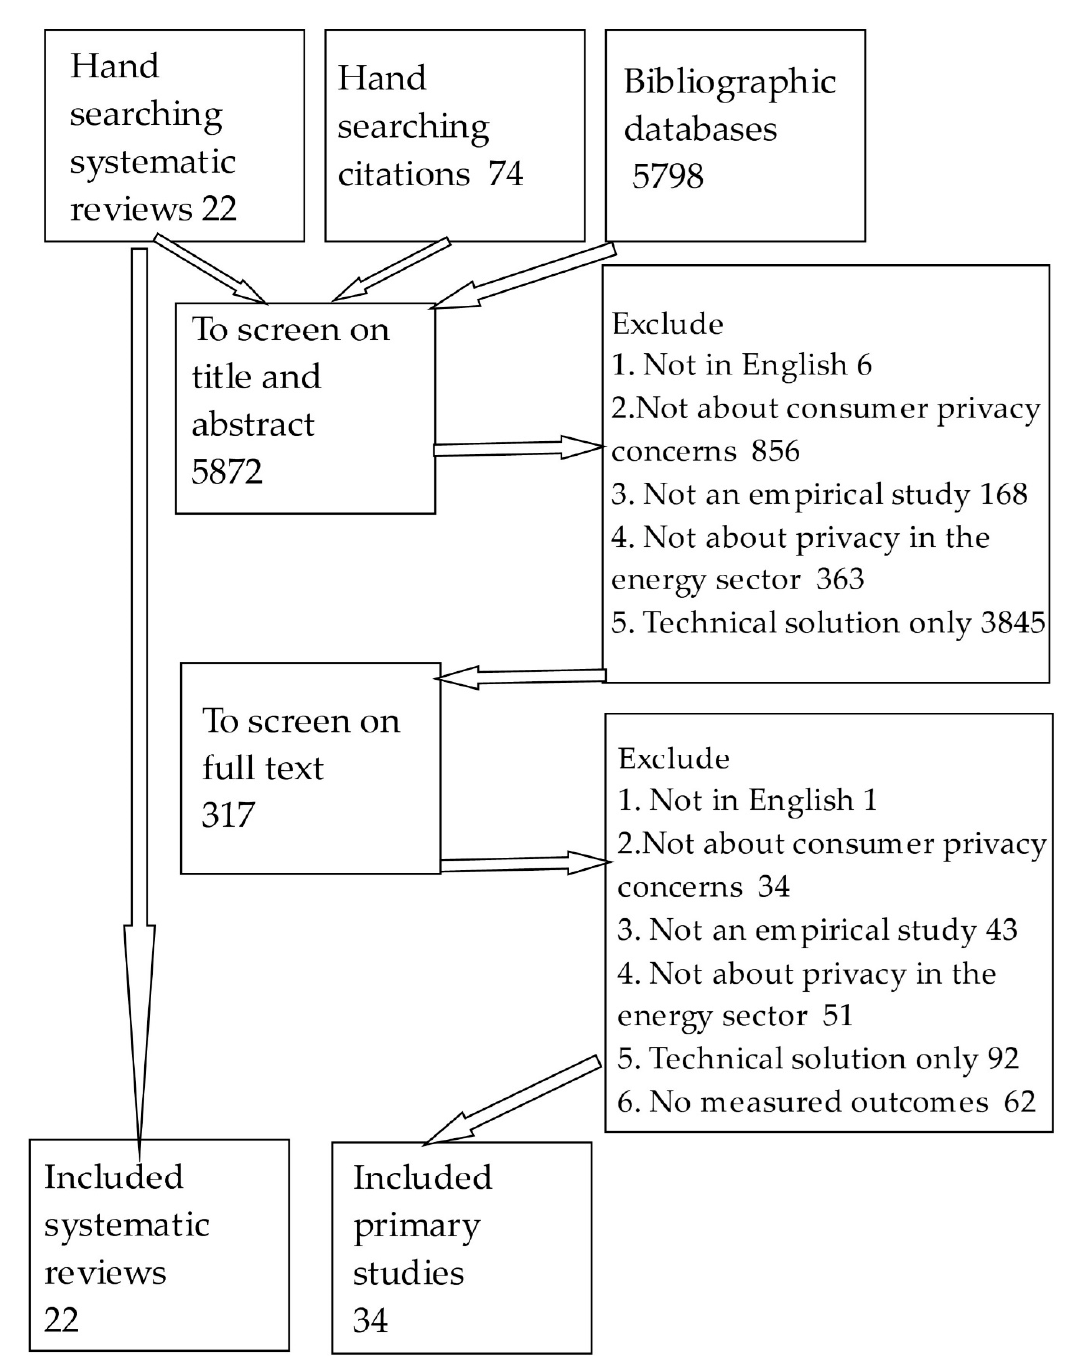
Figure 2. Flow of studies through the realist review